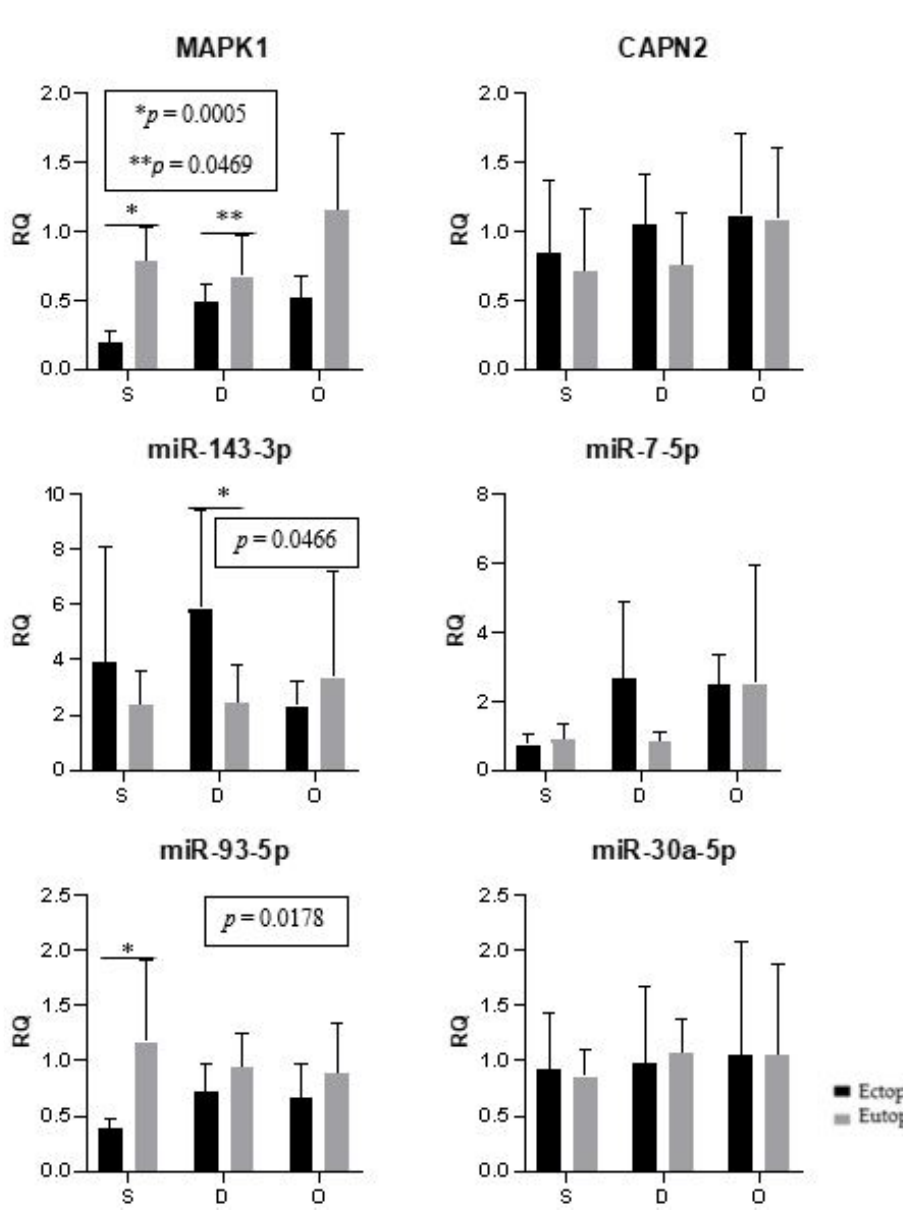
Figure 4. Ectopic lesions and the corresponding eutopic endometrium. Representation of the mean ( ± standard error) gene and miRNA expression in the ectopic lesions and the corresponding eutopic endometrium of women with endometriosis. Superficial peritoneal endometriosis (S) ( n = 10), deep infiltrating endometriosis (D) ( n = 10), and ovarian endometrioma (O) ( n = 10). The groups highlighted with * and ** showed statistically significant differences according to the paired t -test.